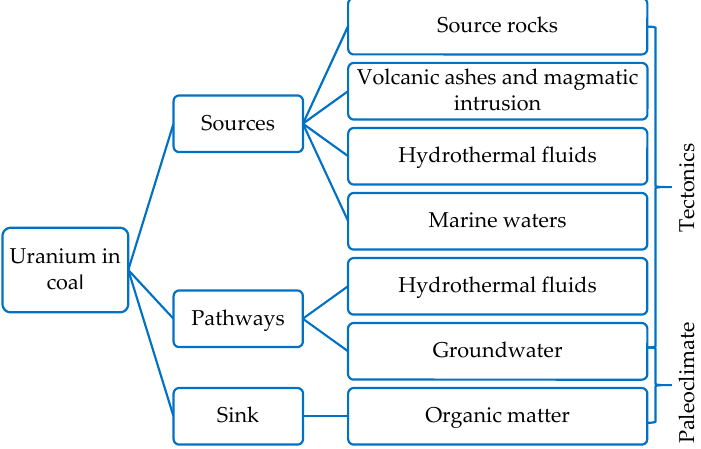
Figure 2. Genetic factors for uranium enrichment in Chinese coals. The schematic diagram is reorganized from Chen et al. [9].